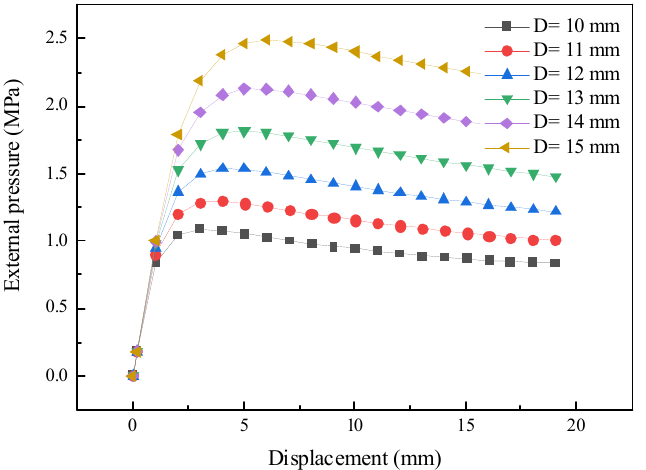
Figure 16. Collapse behavior curve for submarine hose with various helix wire diameters.